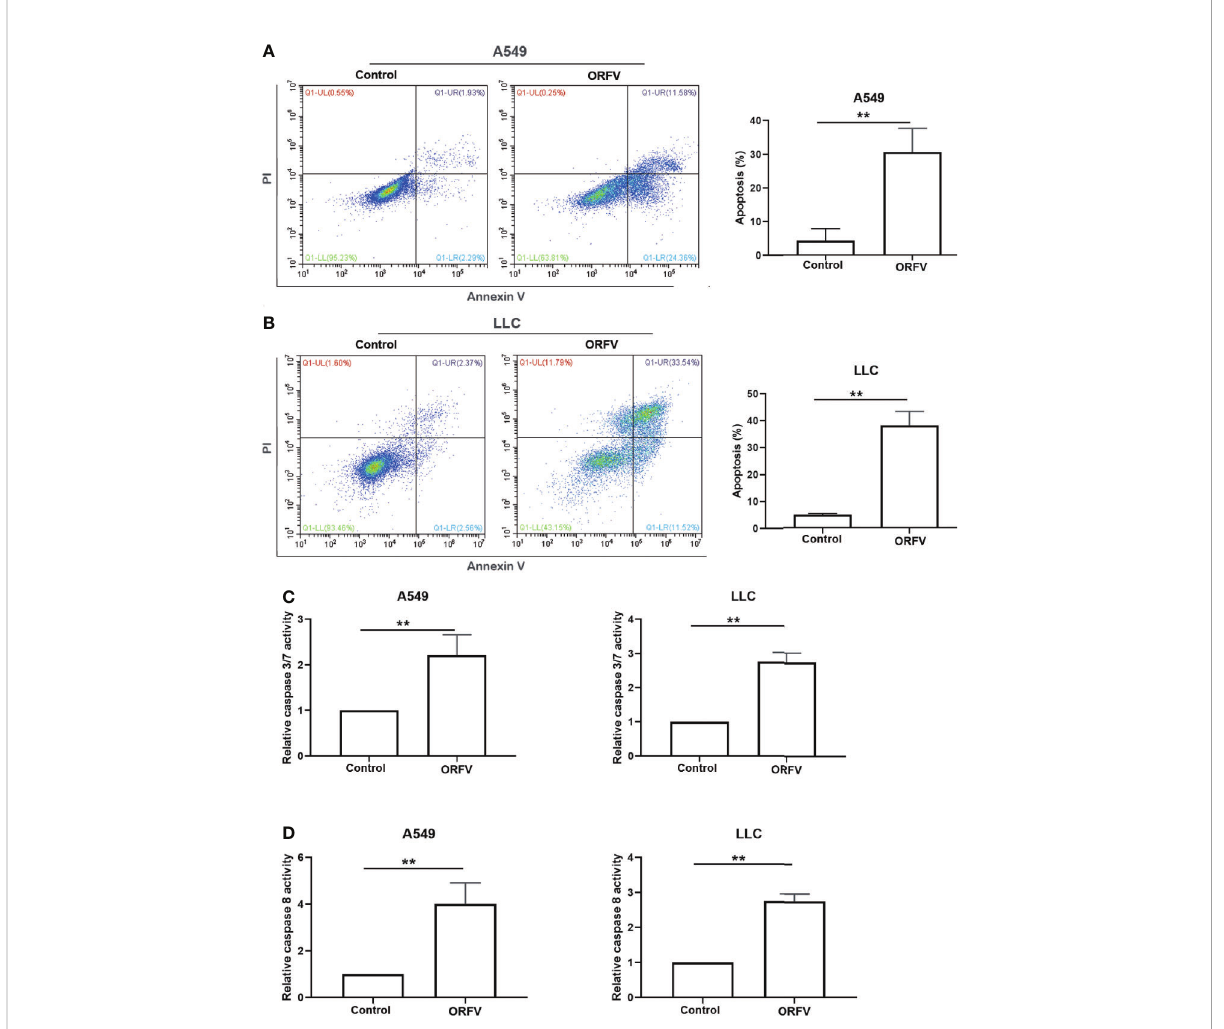
FIGURE 3 ORFV NA1/11 infection induces apoptosis of A549 and LLC cells. (A, B) Flow cytometry analysis of the percentage of apoptotic A549 and LLC cells following infection with, or without, ORFV NA1/11 for 48 hours. (C, D) Analysis of caspase 3/7 and caspase 8 activities in uninfected or ORFV NA1/11 infected (MOI=5) A549 and LLC cells at 24 hpi. The caspase activity was expressed as the relative ratios of the control cells without infection (designated as 1). Data are representative images or expressed as the mean ± SD of each group from three separate experiments.